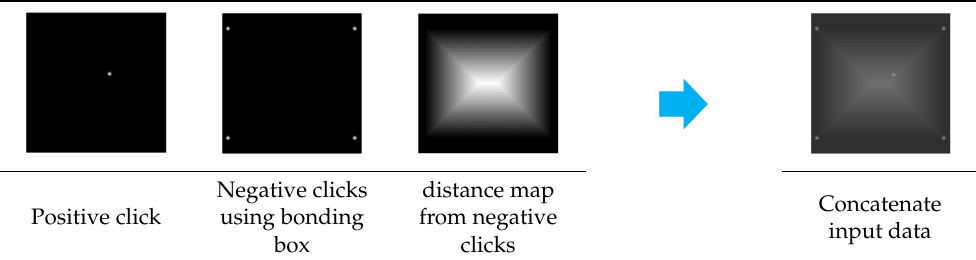
Table 4. Transform–user